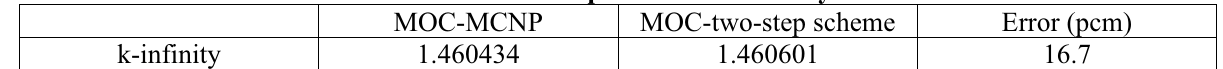
Figure. 6 The Comparison Of 238 U Microscopic Absorption XS in No.2 Rod Table III. Comparison of